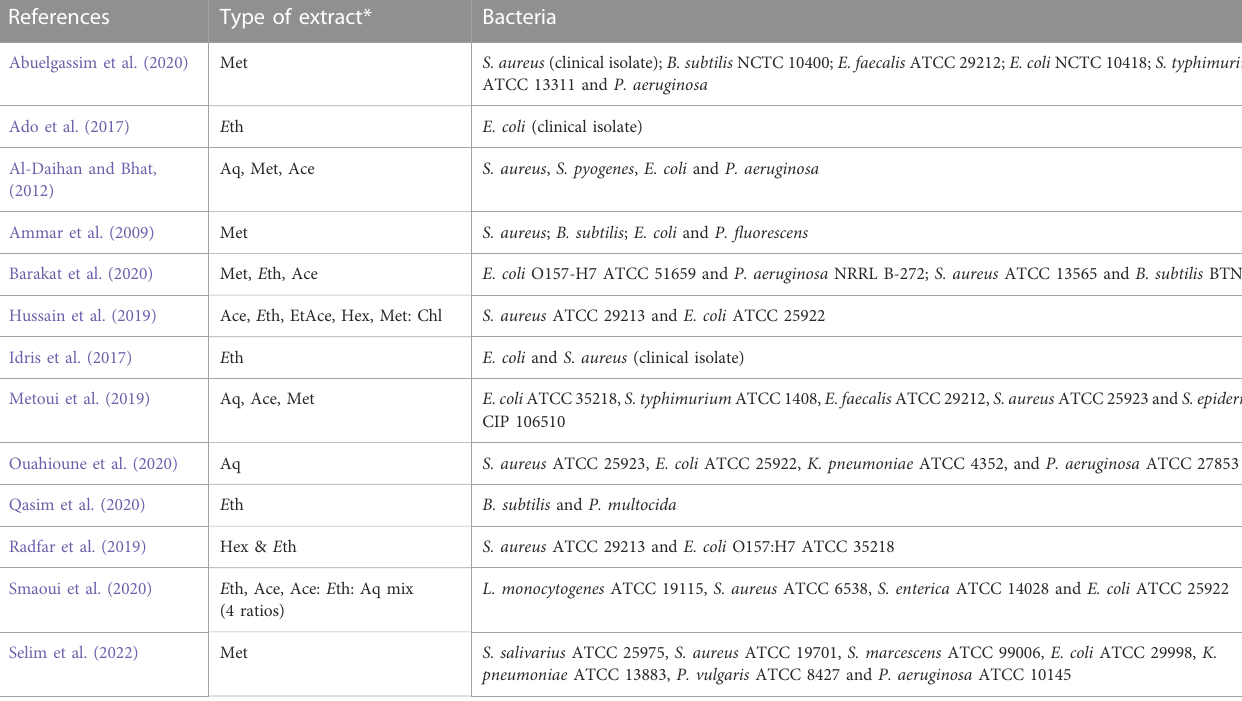
TABLE 2 Overview of selected records reporting antibacterial activity of polyphenols sourced from date kernel